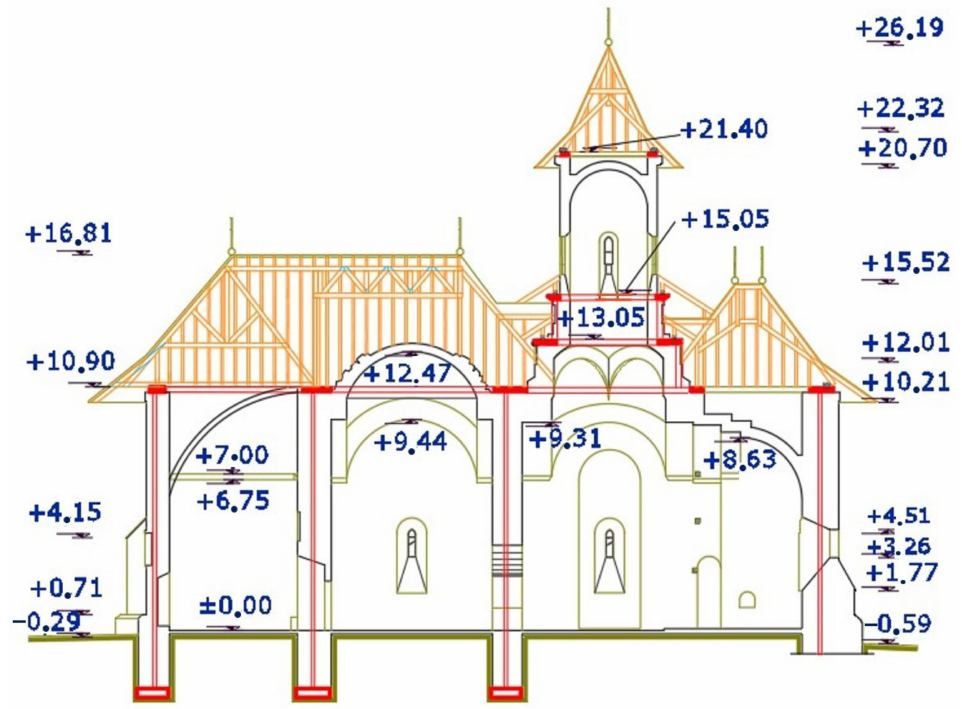
Figure 13. Position of the reinforced concrete girders (dimensions in m).